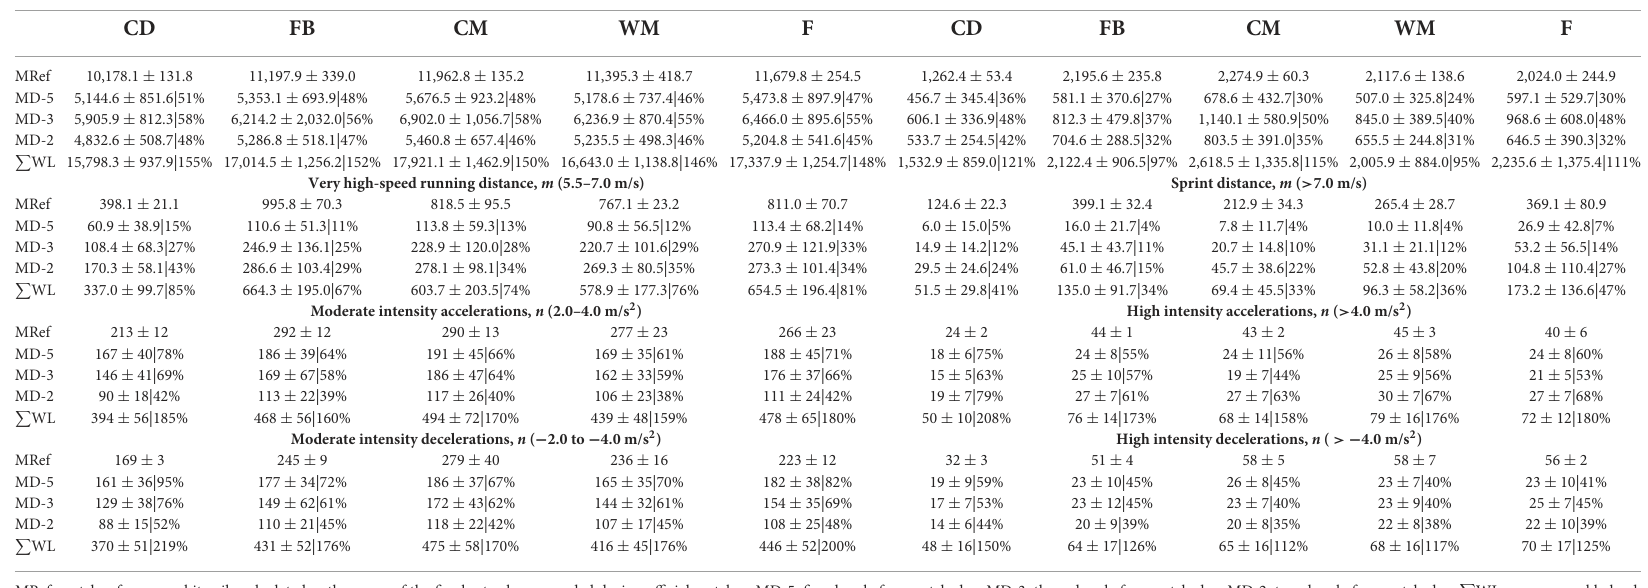
MRef, match reference, arbitrarily calculated as the mean of the five best values recorded during official matches; MD-5, five days before match-day; MD-3, three days before match-day; MD-2, two days before match-day; P WL, average weekly load,